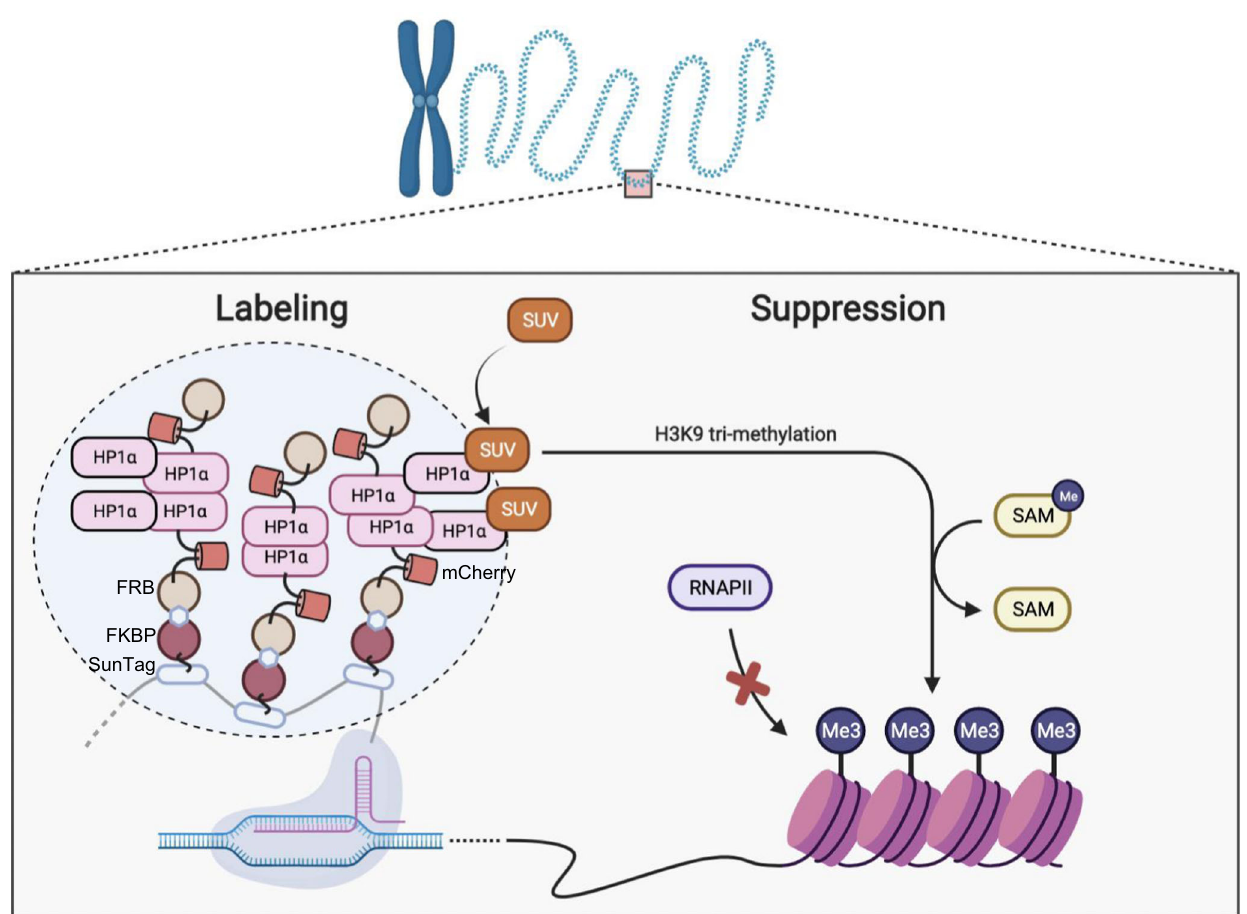
Fig. 6 | A mechanistic diagram showing the inducible SIMBA for concurrent imaging and manipulation of genomic loci in living cells. In the SIMBA system, multivalent HP1 α is recruited to genomic loci via dCas9-24xSunTag (or other DNA binding domains) and chemically inducible FKBP-FRB heterodimerizer, which allows the multilayer polymerization and biomolecular assemblies at speci fi c loci,